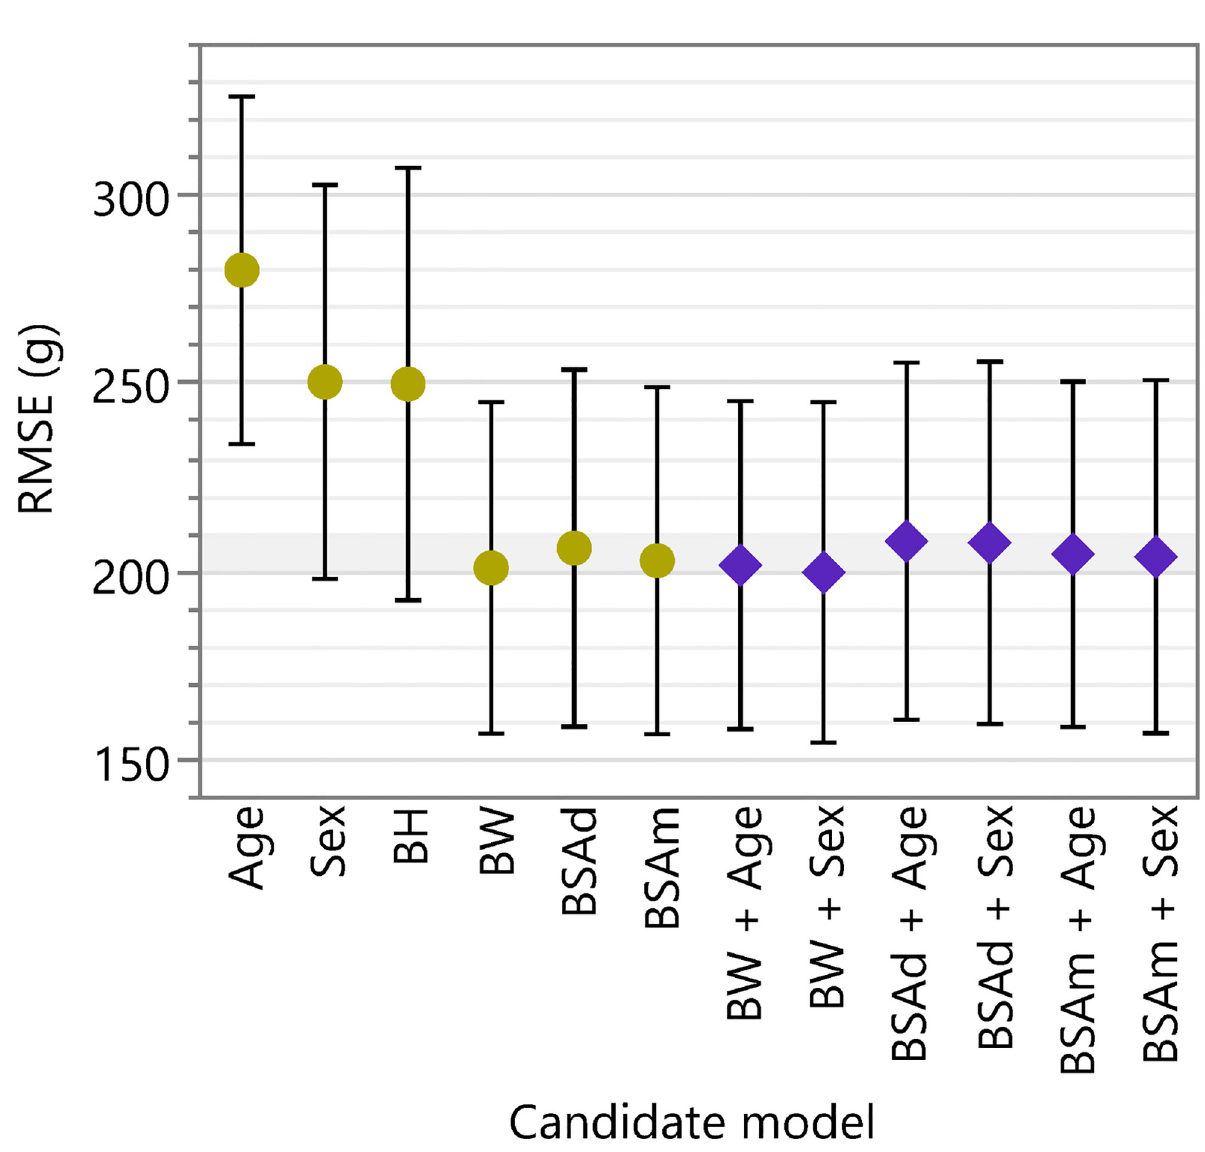
Fig 2. RMSE of the candidate models. The y-axis represents the cross-validation RMSE of the candidate models, i.e., (combination of) candidate independent variable(s). The dots represent the mean, and the bars represent the standard deviation, both across iterations in the “inner” CV. The lower border of the gray band represents the smallest mean among all candidate models. The higher border of the band represents this value multiplied by 1.05. The color and shape of the markers represent the complexity, i.e., the number of independent variables, of the models. RMSE, root-mean-square error; indep vars, independent variables; BW, body weight; BH, body height; BSAd, body surface area (Du Bois and Du Bois), BSAm: body surface area